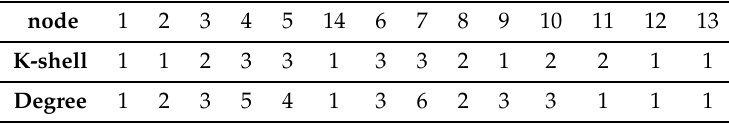
Table 1. Properties of each node in the toy